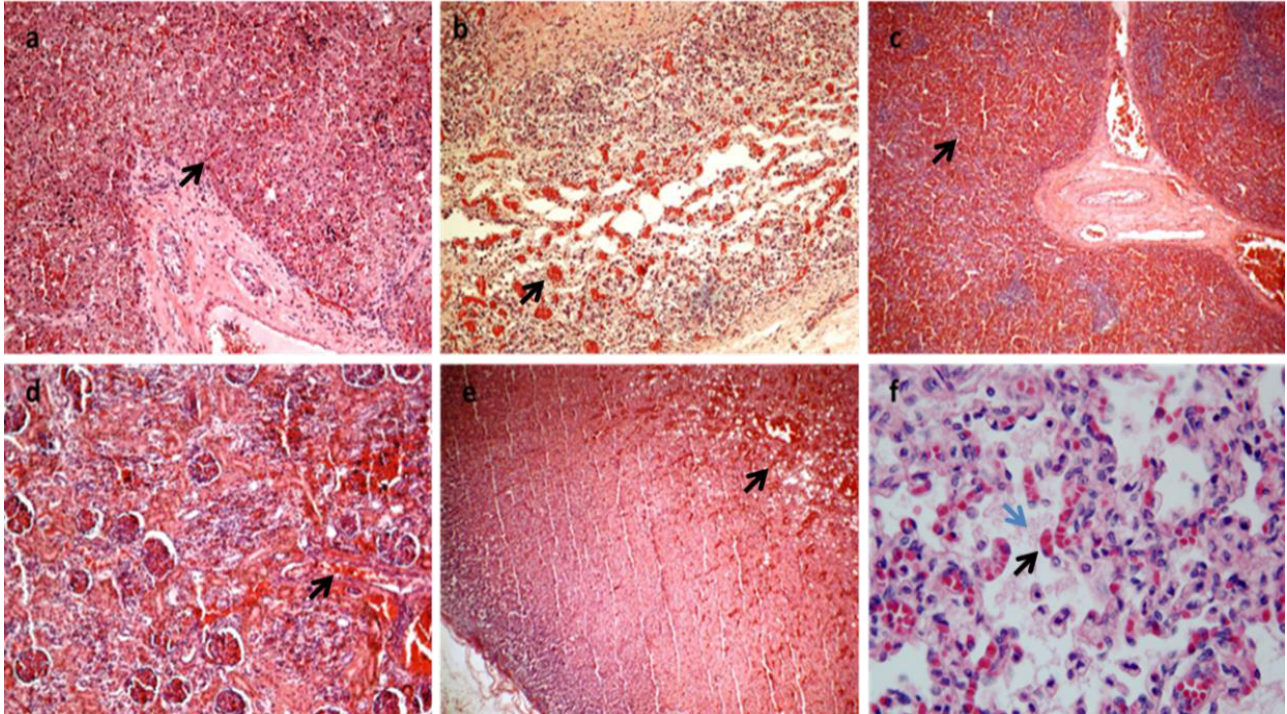
Figure 2. All the organs were macroscopically observed, and samples were taken for each. After formalin fixation and paraffin embedding, sections stained with hematoxylin and eosin were prepared for histological diagnosis [7]. Histology showed multiorgan congestion and lungs in the alveolar-saccular development phase with diffuse congestion with focal aspiration signs ( a – f ). In ( a ): congestion and erythrocyte extravasation in hepatic sinusoids (black arrow) (H&E × 10). In ( b ): congestion and erythrocyte extravasation in the bowel wall (black arrow) H&E × 20). In ( c ): spleen congestion (black arrow) (H&E × 4). In ( d ): kidney congestion (black arrow) (H&E × 20). In ( e ): adrenal gland congestion (black arrow) (H&E × 10). In ( f ): Lungs diffuse congestion (black arrow) with focal intra-alveolar eosinophilic material due to aspiration (blue arrow) (H&E × 63 magnification). (Images from Mansueto’s forensic archive). HLHS is a rare type of congenital heart syndrome. Due to the great number of elective terminations of pregnancy and the spontaneous abortion of affected fetuses, the reported overall incidence is likely underestimated. HLHS is not related to maternal age, ethnicity, or geographical factors. Seven in ten patients are male, and 13.5% of siblings of HLHS patients have some form of congenital heart disease, suggesting a complex relationship with multiple genetic factors [2,6,8]. HLHS is a spectrum of cardiac malformations characterized by a hypoplastic left heart system with atresia, stenosis, or hypoplasia of the mitral and/or aortic valves and hypoplasia of the ascending aorta and arch. In addition to the anomalies of the left heart in HLHS, the cardiac atria and extrapericardial aorta are frequently abnormal, thus constituting a very multifaceted problem that is difficult to classify in a single and only phenotype [6,9,10]. This problem becomes even greater if we consider the existence of single ventricular cardiac anomalies that are associated with other syndromes and if we consider that, in practice, a reduction in the LV to "slit" is quite rare and can be confusing. In addition, the phenotypic variability becomes more marked if we consider the different degrees to which anomalies can occur. In any case, the left heart is insufficient and fails to sustain systemic cardiac output. Paradoxically, a functional intrauterine diagnosis is easier than an anatomopathological diagnosis if the heart is in the hands of a non-expert. As regards the physiology of the well-being of the newborn with HLHS, in order to maintain adequate systemic and pulmonary circulation, it is necessary that the exchanges between the left and right cardiac systems are open at birth: (1) the patency of the Botallo duct can ensure systemic perfusion from the right ventricle to the aorta; (2) the foramen ovale or an atrial defect can provide adequate mixing of oxygenated